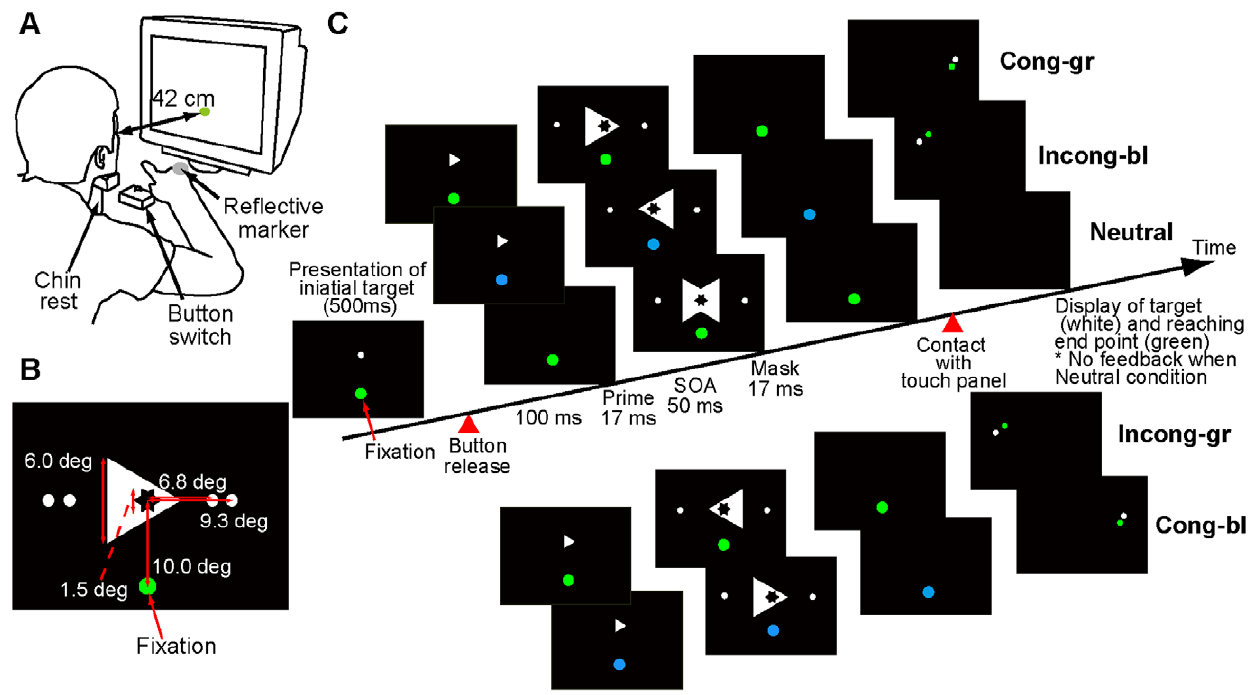
Figure 1. Experimental setup and protocol. (A) Configuration of the experimental apparatus. Participants rested their heads on the chin rest and were required to make reaching movements from the button switch to the target displayed on the monitor while they watched the fixation point. The motion of the reflective marker was recorded by the motion capture system as the kinematics of the reaching movement. (B) Visual stimulus layout. The diameter of the fixation point participants were asked to watch during the trials was 0.85 deg (shown as a green filled circle). Right- or left-pointing prime and mask stimuli were regular triangles whose sides were 1.5 and 6.0 deg, respectively. The centroid of the prime triangle was located at 10 deg above the fixation point in the vertical plane. Possible targets (white filled circle, diameter of 0.6 deg) were located at 6.8 and 9.3 deg horizontally from the centroid on each side, respectively. (C) Time sequence of the visual stimuli (prime-mask combination) in each condition. While the fixation point remained green in the congruent(incongruent)-green and neutral conditions after the button release, the color of the fixation point was switched from green to blue in the incongruent(congruent)-blue conditions at the same timing of prime onset. The outer contour of the prime stimuli fit exactly within the inner contour of the cutout of the mask triangles. Except for trials in the neutral condition, either the right- or left- target point (white filled circle, diameter: 0.6 deg) reappeared according to the direction of the mask stimulus, and feedback about the reaching endpoint (green filled circle, diameter: 0.6 deg) was also provided after the reaching movement (i.e., contact with touch panel).